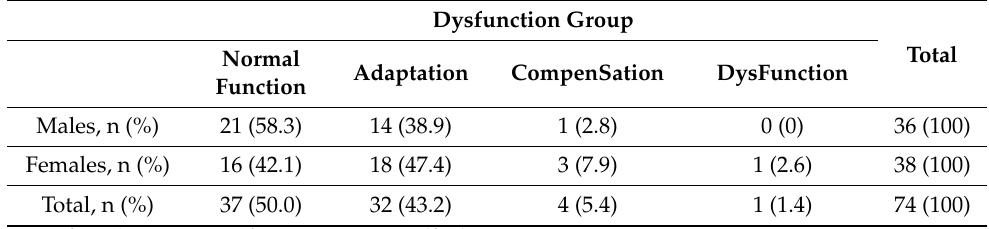
Table 2. Distribution of dysfunction groups according to the Graz Dysfunction Index, by gender.